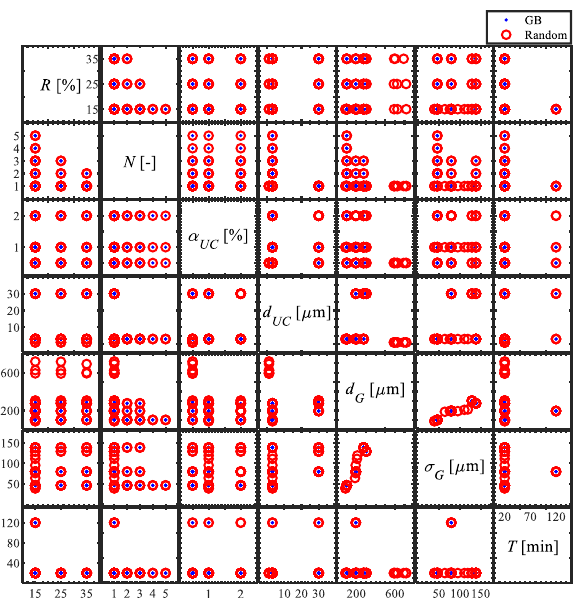
Figure 6. Distribution of the input parameters in the matrix plot